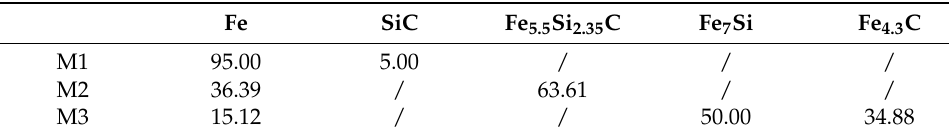
Table 2. Composition of the powder blends M1, M2, and M3 (wt.